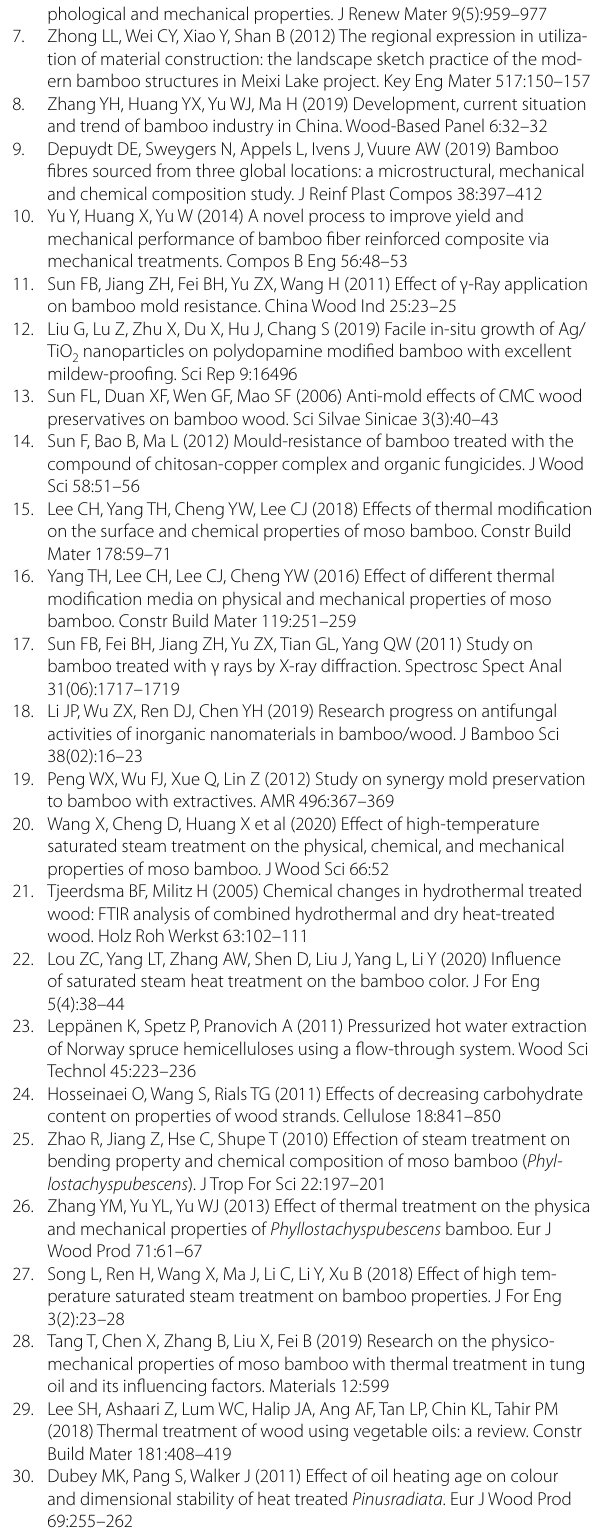
Additional file 1: Figure S1. ( a ) AFM images of the interface between the untreated (left) and treated (right) bamboo surface. ( b ) Corresponding cross-sectional profile for the green dashed line. Figure S2. Pictures of untreated sample ( a ) and the treated samples treated ( b1‑b3 ) at 140 °C for varied time (2 h, 4 h and 6 h), ( c1‑c3 ) at 160 °C for varied time (2 h, 4 h and 6 h), ( d1‑d3 ) at 180 °C for varied time and ( e1‑e3 ) at 200 °C for varied time (2 h, 4 h and 6 h), (2 h, 4 h and 6 h),